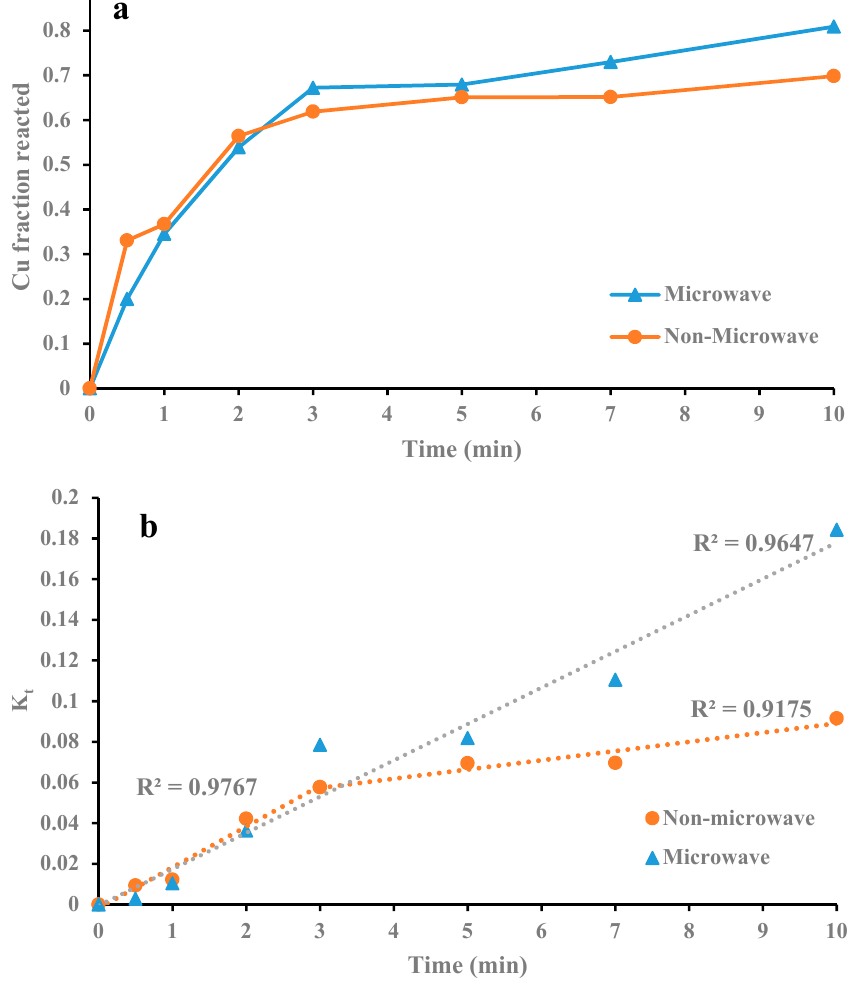
Figure 10. Copper extraction ( a ) and plot of K t versus time for copper leaching in presence and absence of microwave irradiation ( b ).